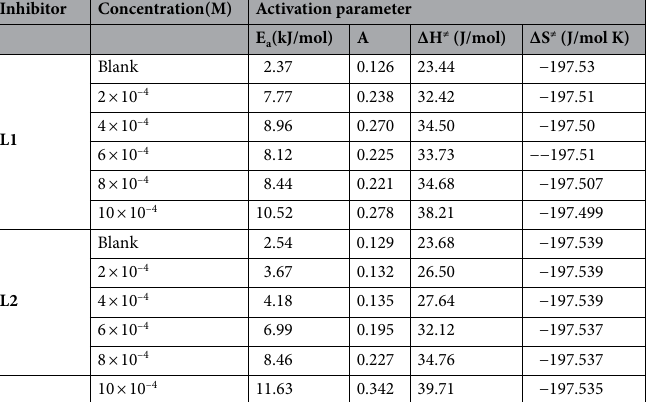
Table 3. Activation energy (Apparent) ( E a ), A, ΔH * , ΔS * of L1 and L2 at different concentrations derived from Arrhenius and Transition State